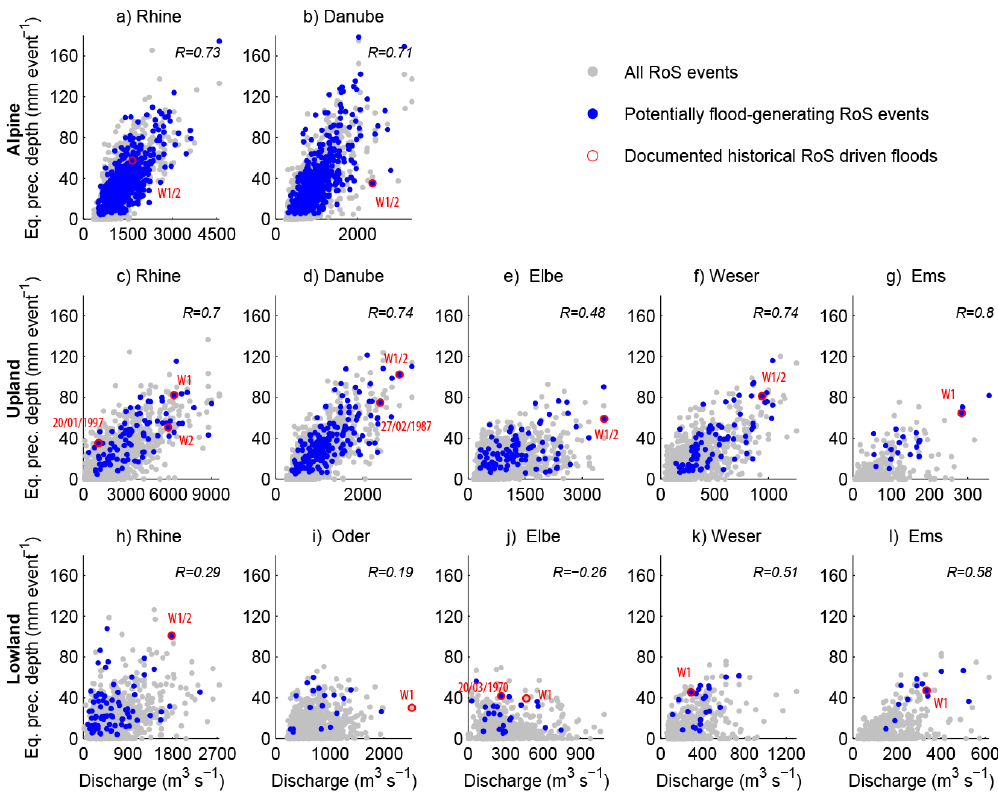
Figure 3. Total equivalent precipitation depth and corresponding peak discharge for all possible RoS events (SP > 0mm SWE, M > 0%, P L ≥ 0mm), for all potentially flood-generating events (SP > 10mm SWE, M > 20%, P L ≥ 3mm), and for documented historical RoS- driven floods. The correlation coefficient R is given for the potentially flood-generating RoS